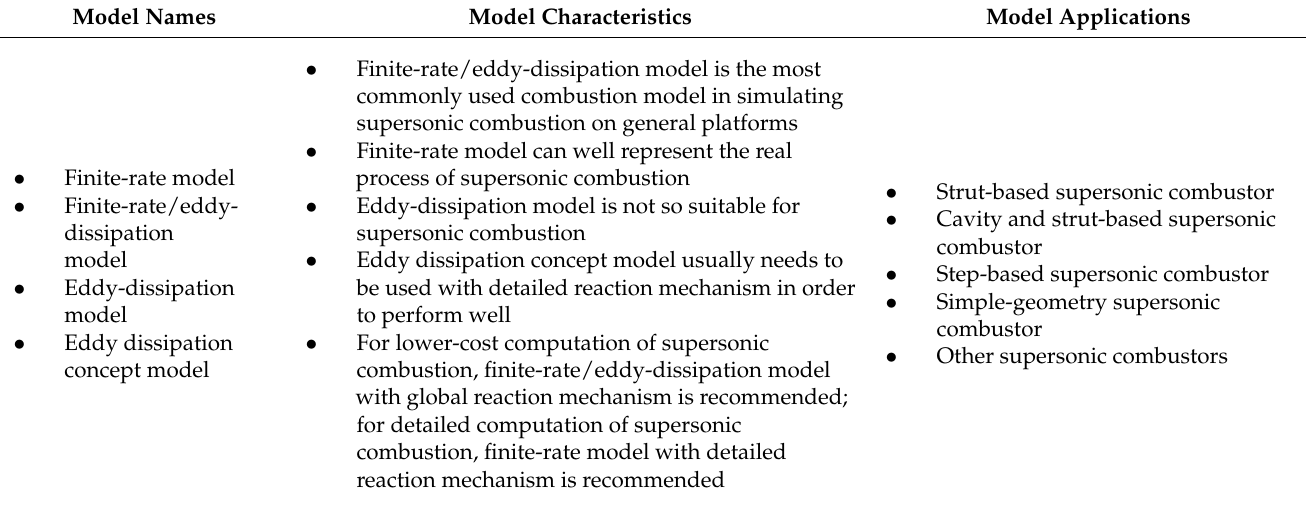
Table 3. Combustion models commonly used for supersonic combustion on general